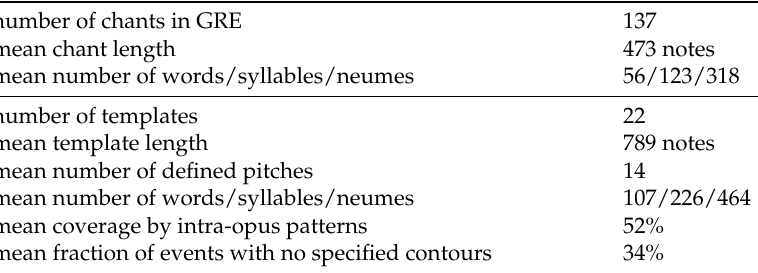
Table 2. Description of the GRE corpus (top) and the 22 templates